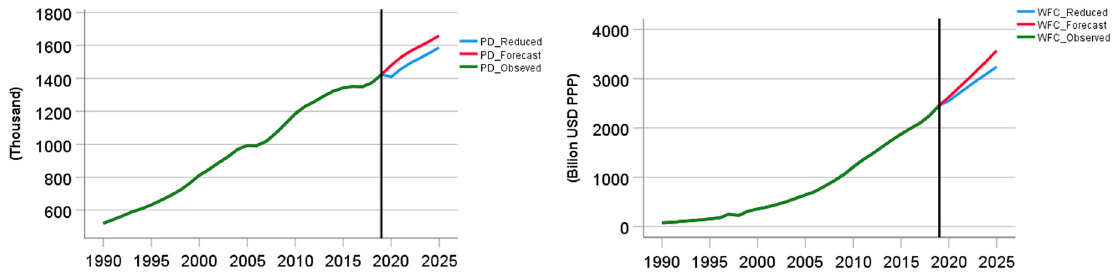
Figure 15. Predicted premature deaths ( left ) and welfare costs ( right ) from 2020 to 2025 for two scenarios: one with and one without the effect of COVID-19 lockdown measures on air pollution.